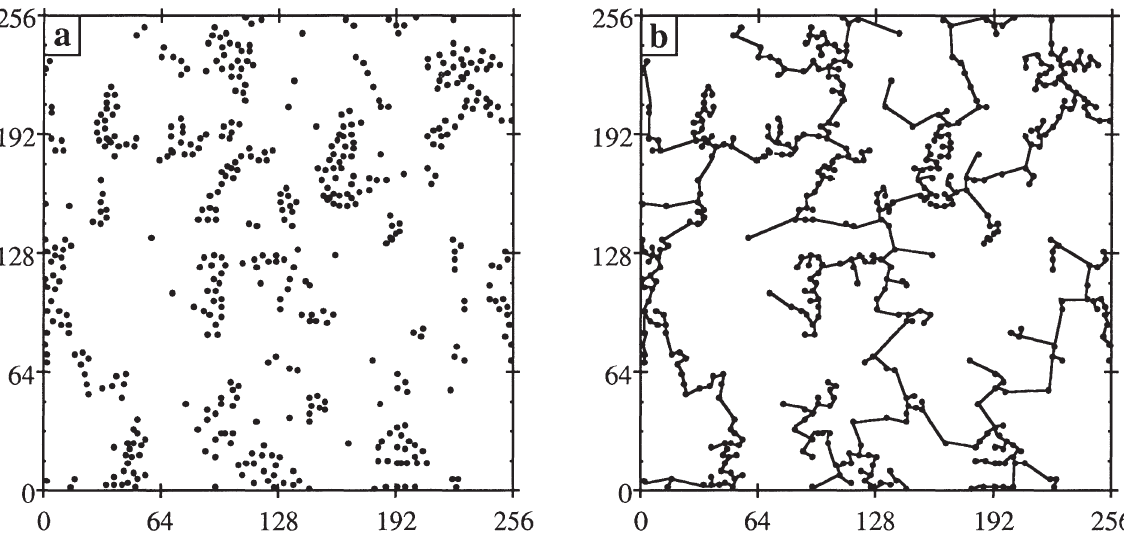
Fig. 2. (a) Position of MCF-7 cells of the initial configuration. Only 256 × 256 points of the image are represented. (b) Minimal spanning tree (MST) concerning the distribution of